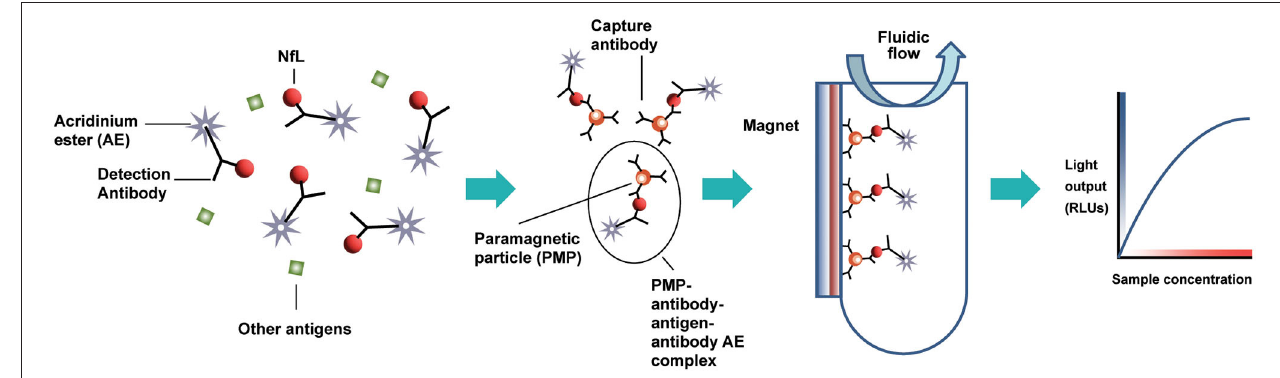
FIGURE 1 | Acridinium ester-based automated immunoassay workflow, as implemented on the Siemens Centaur ® and Atellica ® testing platforms. AE, acridinium ester; PMP, paramagnetic particle; RLUs, relative light units.